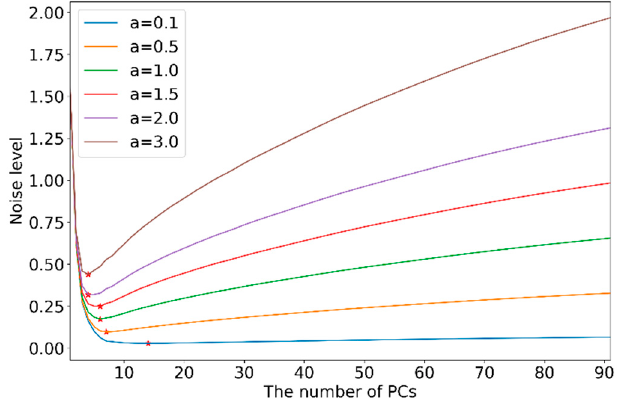
Figure2. RelationshipbetweenthenoiselevelandtheoptimumnumberofPCsofthe91uncontaminated Figure 2. Relationship between the noise level and the optimum number of PCs of the 91 channels with a values of 0.1, 0.5, 1.0, 1.5, 2.0, and uncontaminated channels with a values of 0.1, 0.5, 1.0, 1.5, 2.0, and 3.0.